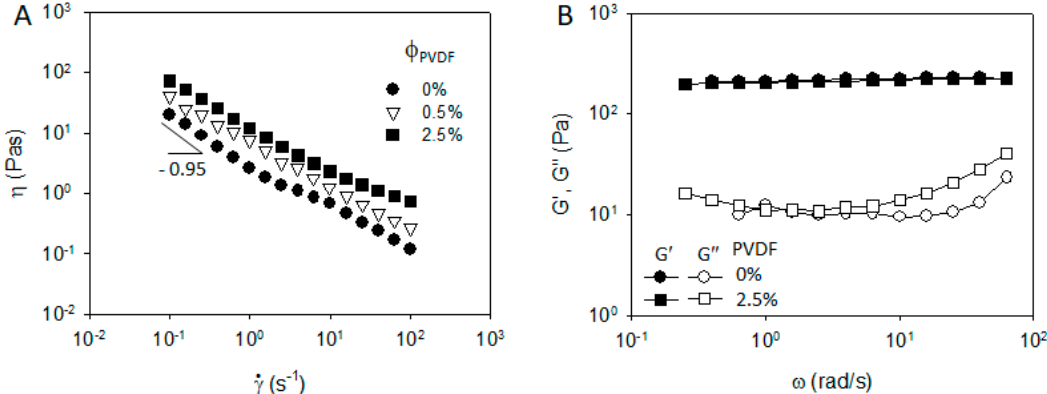
Figure 1. ( A ) Steady shear viscosity and ( B ) frequency dependent storage and loss modulus of carbon black (CB)/Poly(vinylidene fluoride) (PVDF)/N-Methyl-2-pyrrolidone (NMP) mixtures of 3 wt% (=1.3 vol%) of CB with a varying polymer concentration.